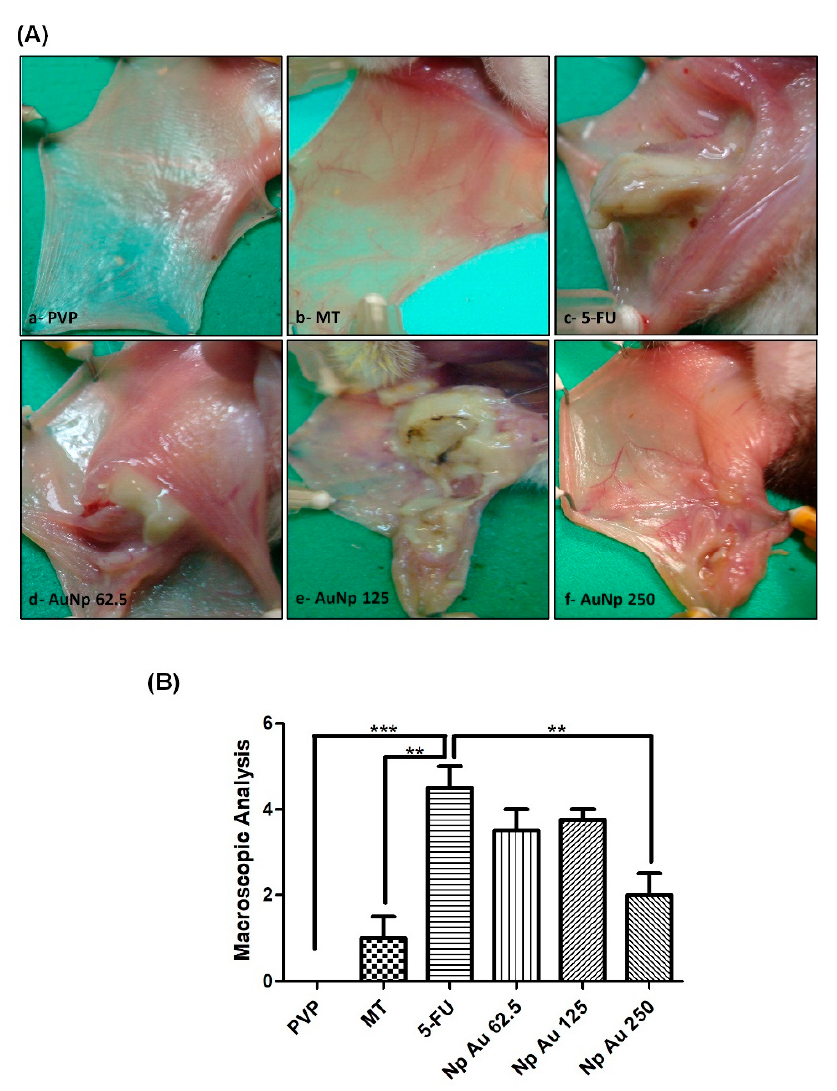
Figure 1. ( A ) Macroscopic analysis of the oral mucosa of hamsters (golden sirian) with oral mucositis (OM) induced by 5-fluorouracil (5-FU) and mechanical trauma (MT). PVP group: Animals with healthy, no erosion or vasodilatation of the oral mucosa, these hamsters only received PVP solution via i.p. (It is appropriate) or 10 days ( a ). Mechanical trauma (MT) group: Animals submitted to excoriation on the 10th day of the experimental model, the oral mucosa showed vasodilation and erythema ( b ). The 5-FU group: Animals that developed OM by administering 5-FU (IP) and mechanical trauma, the group showed oral mucositis characterized by ulcer formation, severe erythema, and vasodilation ( c ). The groups with OM treated with AuNp 62.5 ( d ), 125 ( e ), or 250 μ g/kg (IP) ( f ). The animals treated with AuNp 250 μ g/kg had mild vasodilation and superficial erosion in the oral mucosa, with no evidence of ulcers. ( B ) Score graph with the standard error of the mean ( n = 5/group). ** p < 0.001; *** p < 0.0001 (Kruskal–Wallis test and Dunn’s multiple comparison test).